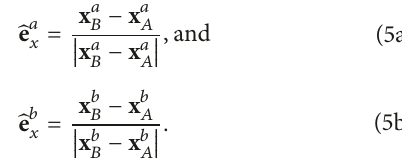
Figure 2: Local coordinate system of space beam